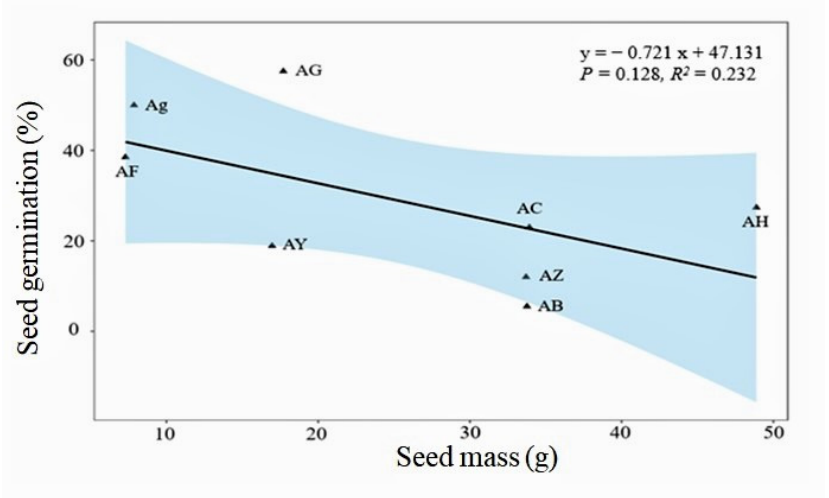
Figure 2. Compared with other Abies endemic to China, Abies beshanzuensis had low germinability. AB: Abies beshanzuensis , AC: Abies chensiensis , AF: Abies fargesii , AG: Abies georgei , Ag: Abies georgei var. smithii , AH: Abies holophylla Maxim , AY: Abies yuanbaoshanensis , AZ: Abies ziyuanensis . The blue-colored area is the 95% confidence interval.